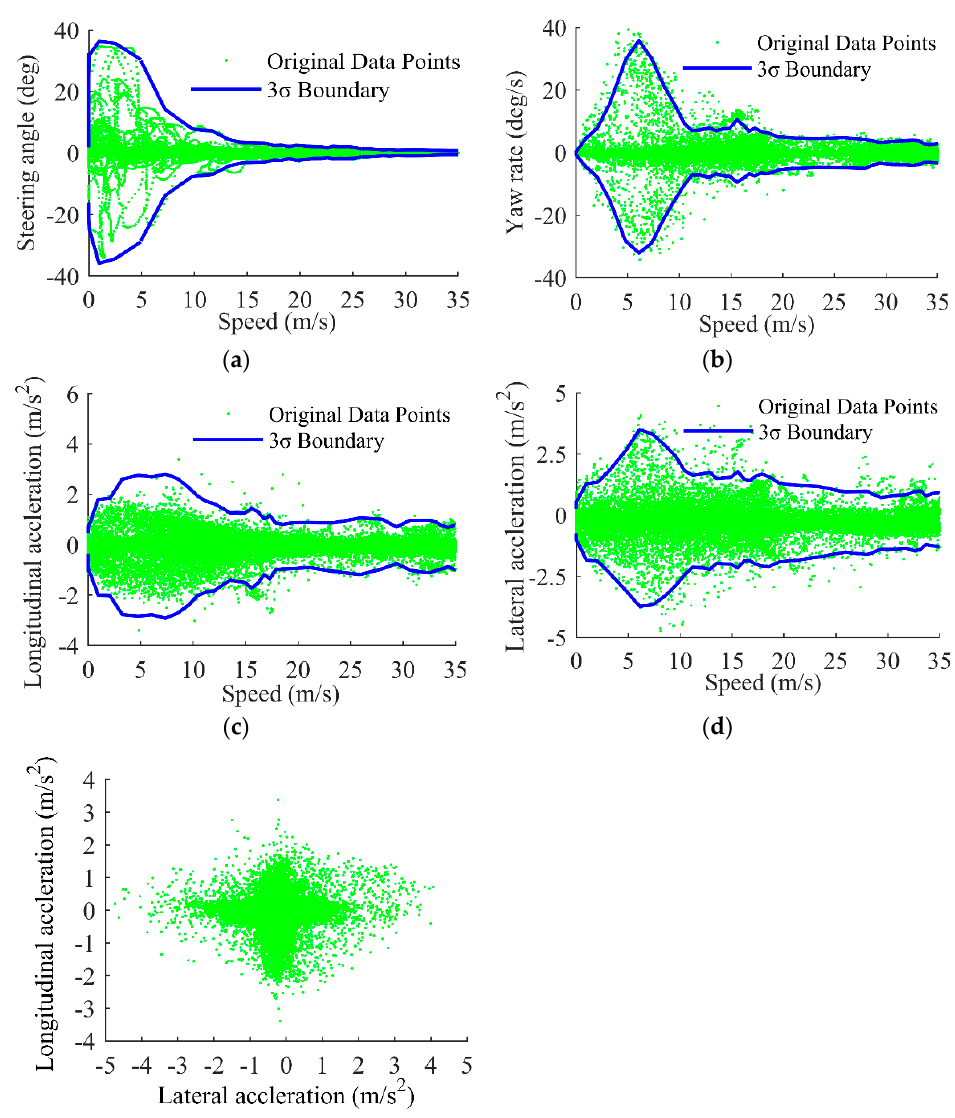
Figure 2. Statistical results of natural driving data: ( a ) steering angle; ( b ) yaw rate; ( c ) longitudinal acceleration; ( d ) lateral acceleration; ( e ) the graph of lateral and longitudinal acceleration in X-Y.